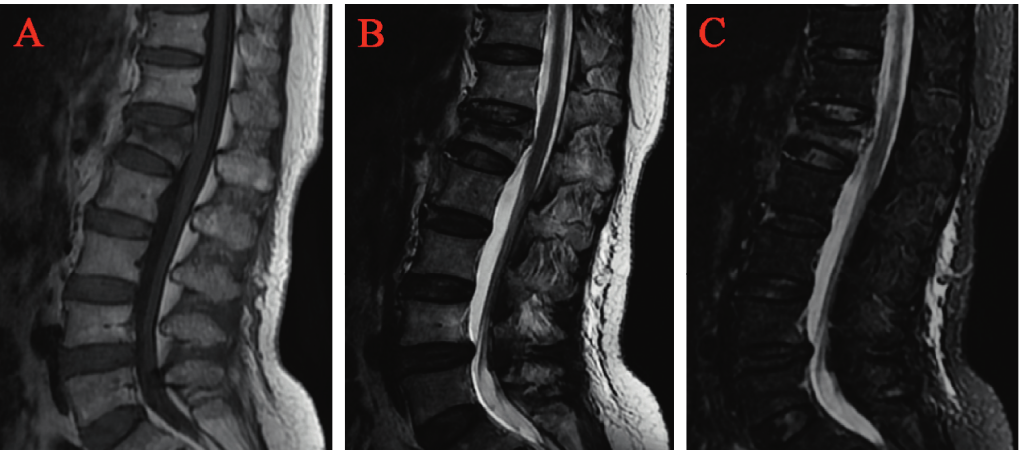
Figure 4: Posterior fascia oedema of osteoporotic vertebral compression fractures was visible on (a) T1 WI, (b) T2 WI, and (c) T2-STIR WI of